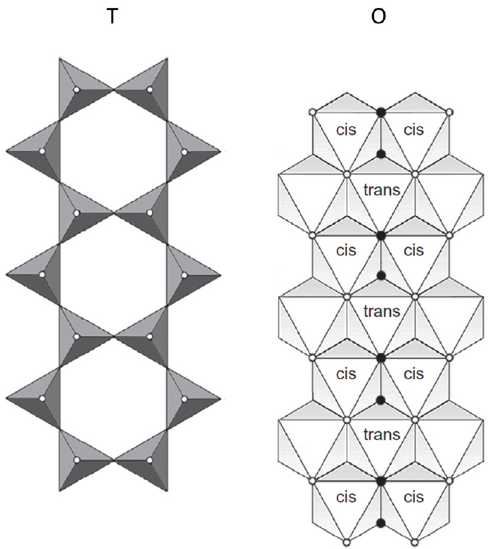
Figure 4. The structure of (T) tetrahedral sheet and octahedral sheet (O) in which the open circles represent the linkages between sheets. The octahedral sites are indicated as trans (M1) or cis (M2) based on the arrangement of hydroxyl ions. The filled circles represent the OH ions in trans-position, which introduce a plane of symmetry in the octahedral sheet. Reprinted from [22] with permission from Elsevier (License Number 5172351427456).